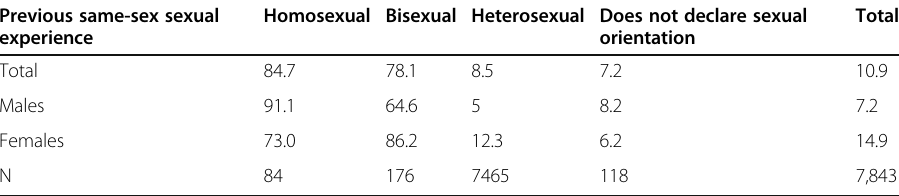
Table 1 Percentage of students who declare previous same-sex sexual experience by gender and sexual